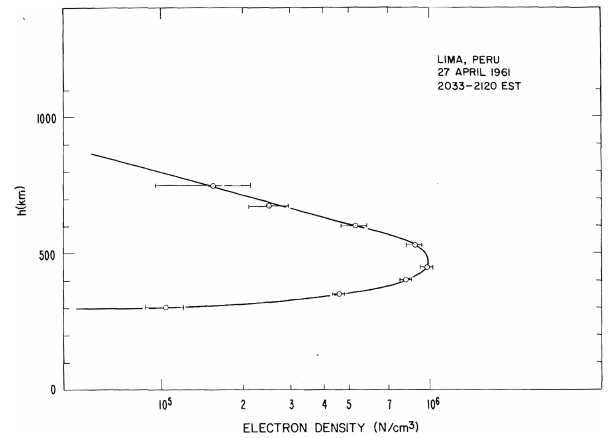
Figure 8. Installation of the last ceremonial golden array element in April 1962. In the picture are Gerard Ochs, Hector Cabada, Ger- ardo Vera, and Antonio Arévalo (picture provided by Gerry